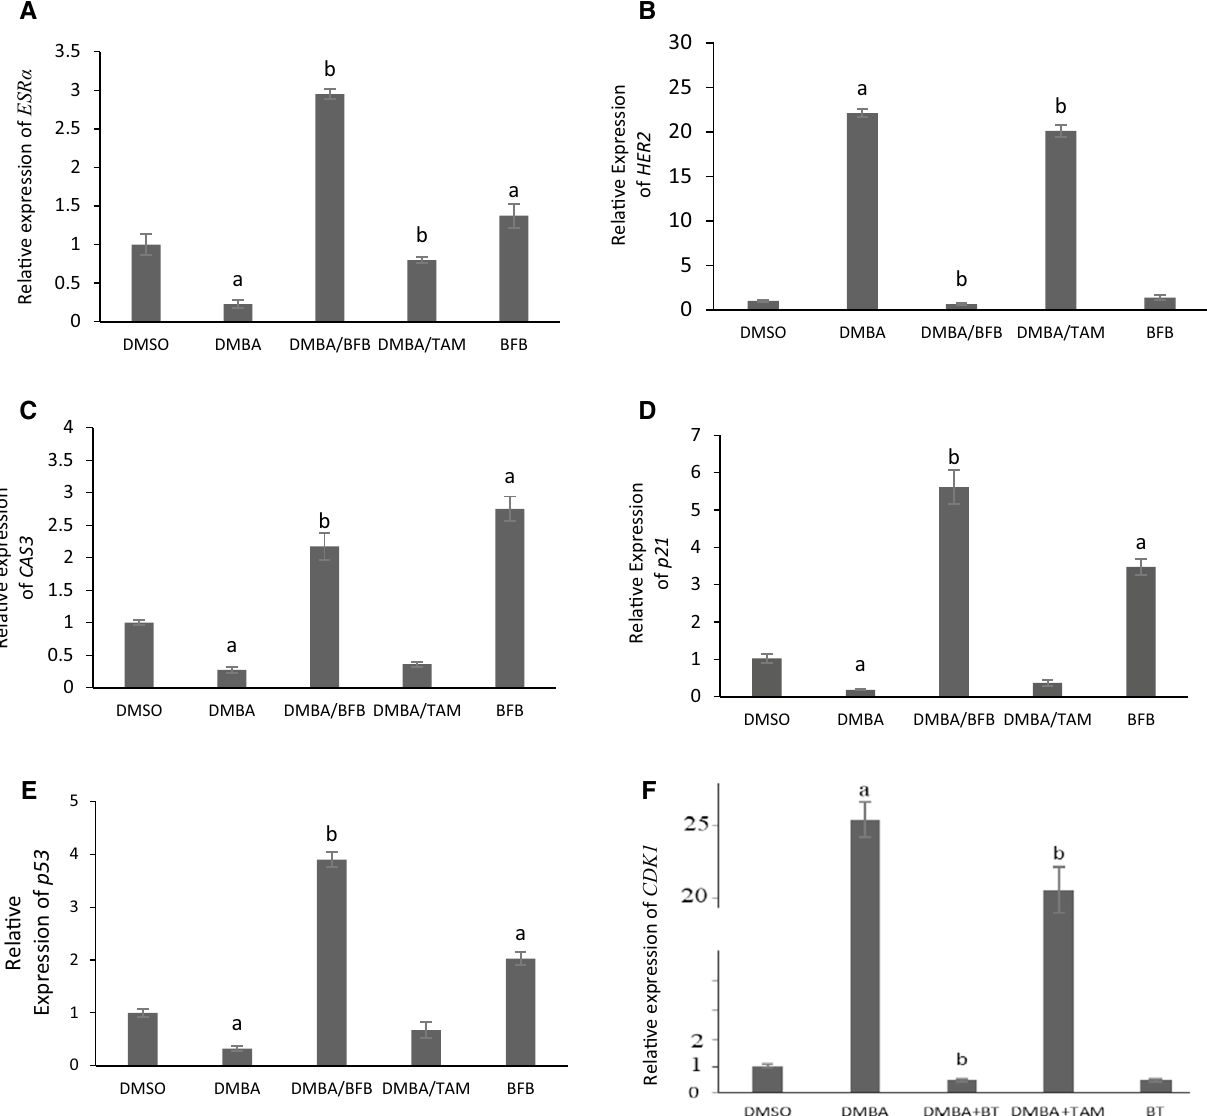
Fig. 2 Relative Expression of A ESRα B Erbb2 (HER2) C CAS3 D CDKN1A (p21) E p53 and F CDK1 genes in mammary tissue. Data are shown as Mean ± SD, n = 5. a Significant vs. control, b Significant vs.